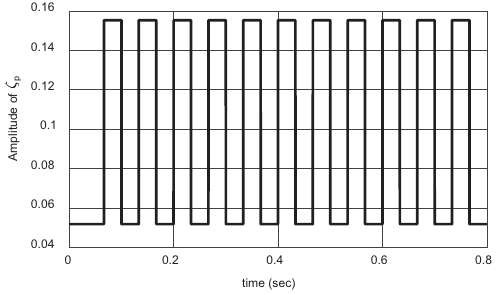
ξ amplitude in ideal ON-OFF 2 φ